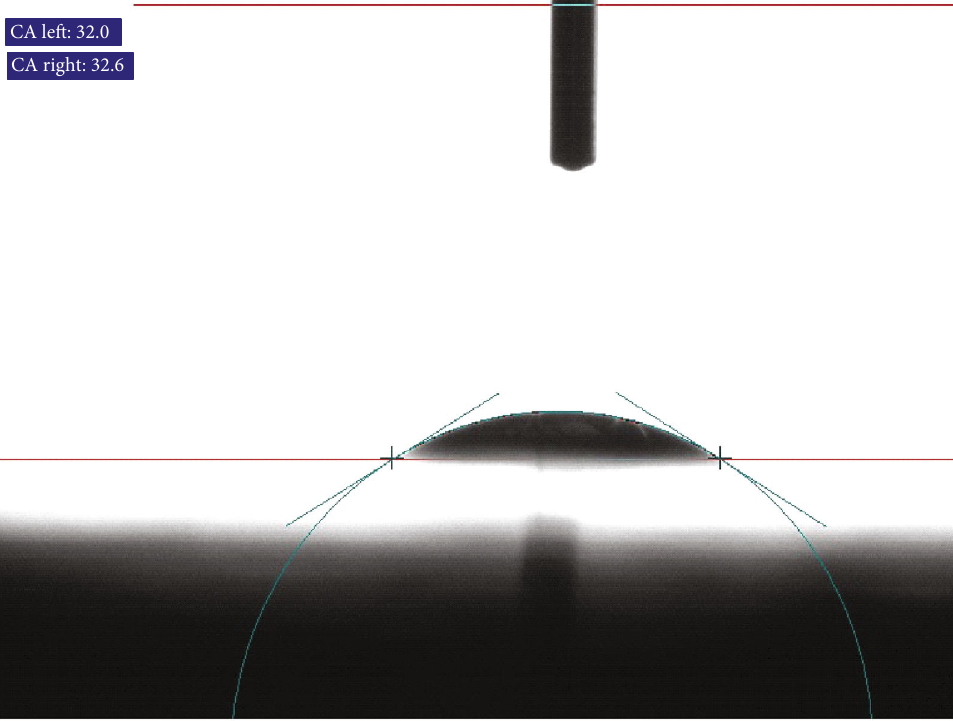
Figure 6: Contact angle and water droplet shape of wind turbine blade without coating.